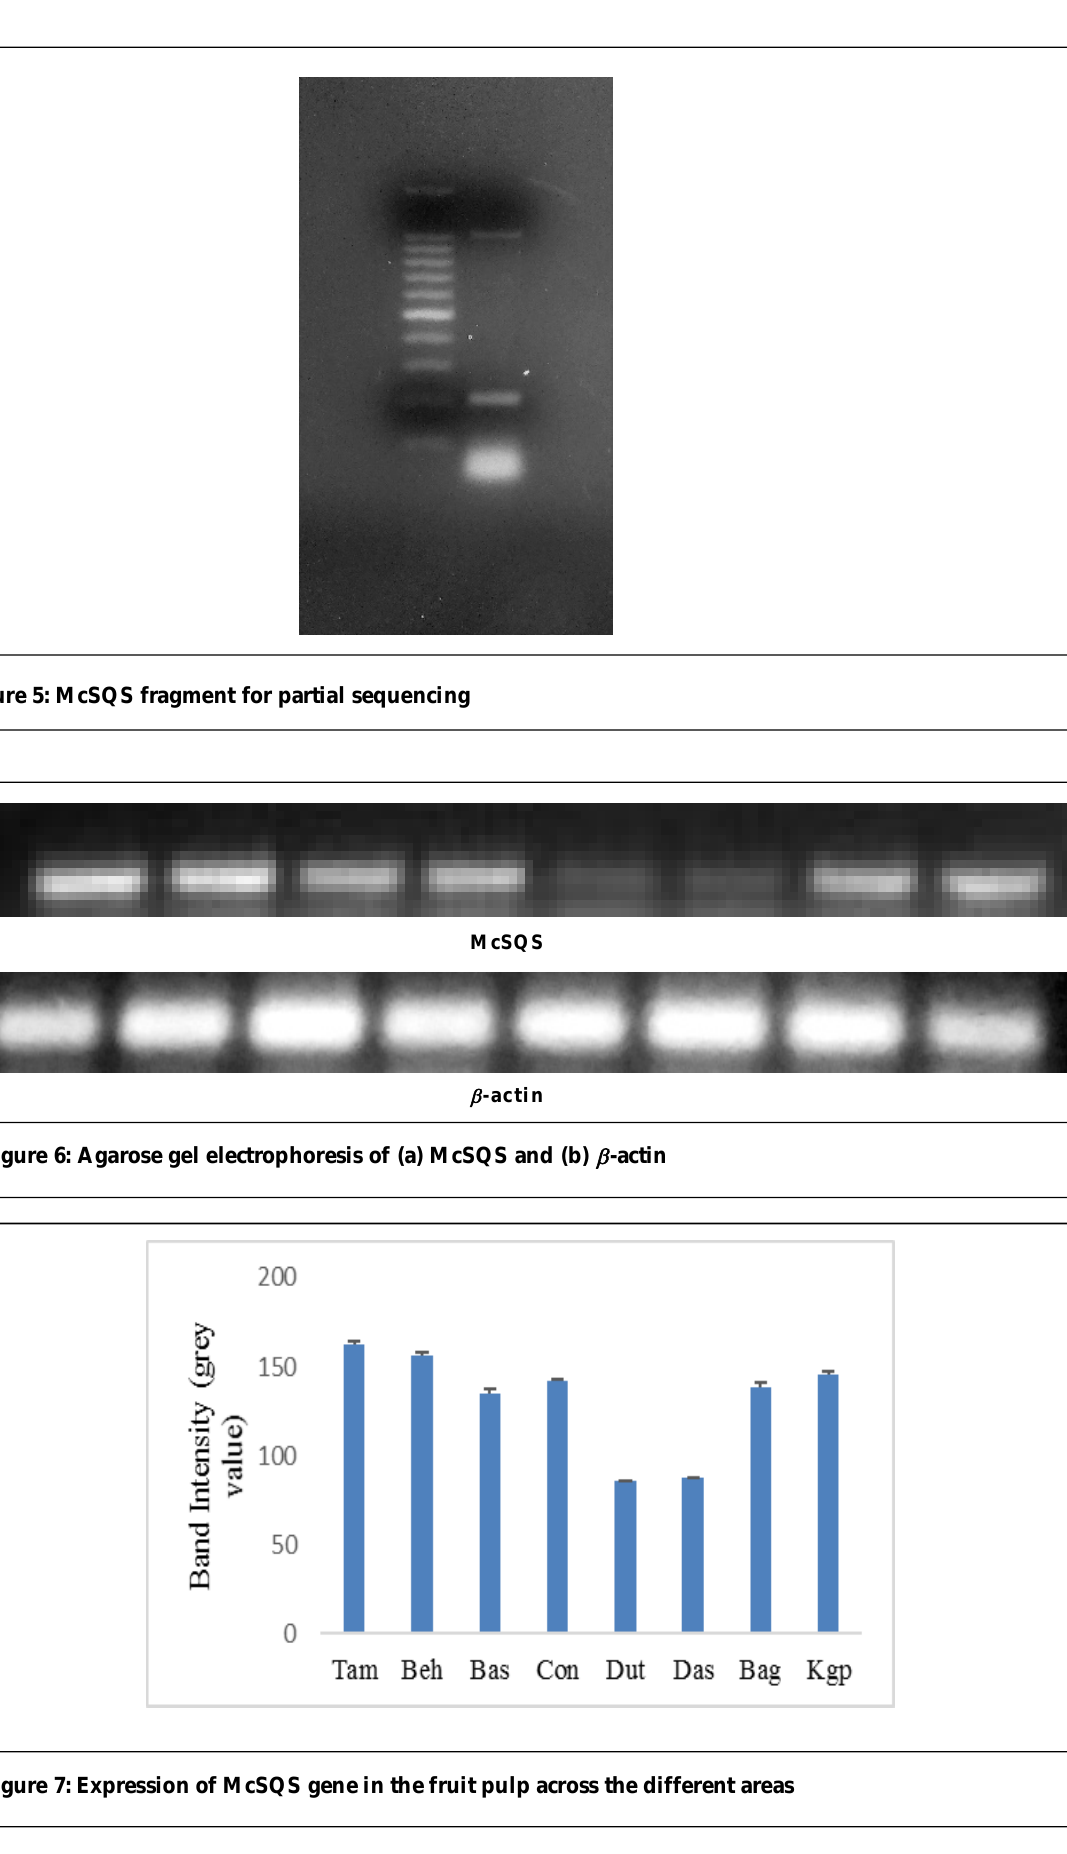
Figure 7: Expression of McSQS gene in the fruit pulp across the different